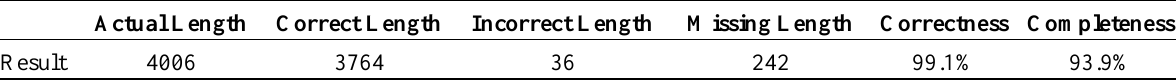
Table 2. Correctness and completeness of the extracted power line points.